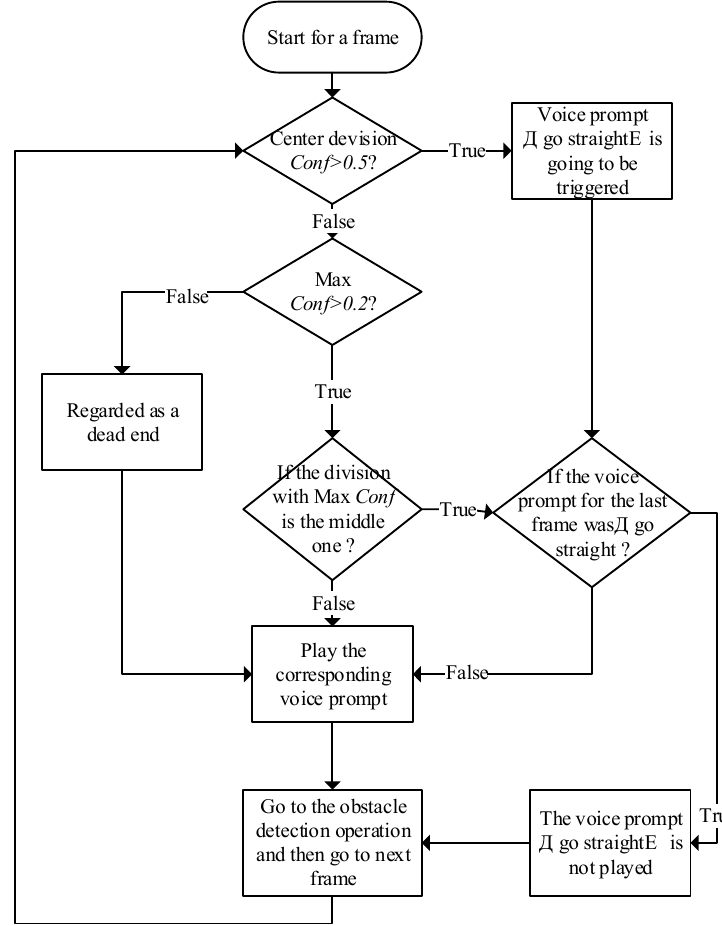
Figure 8. The flowchart of the walking guide